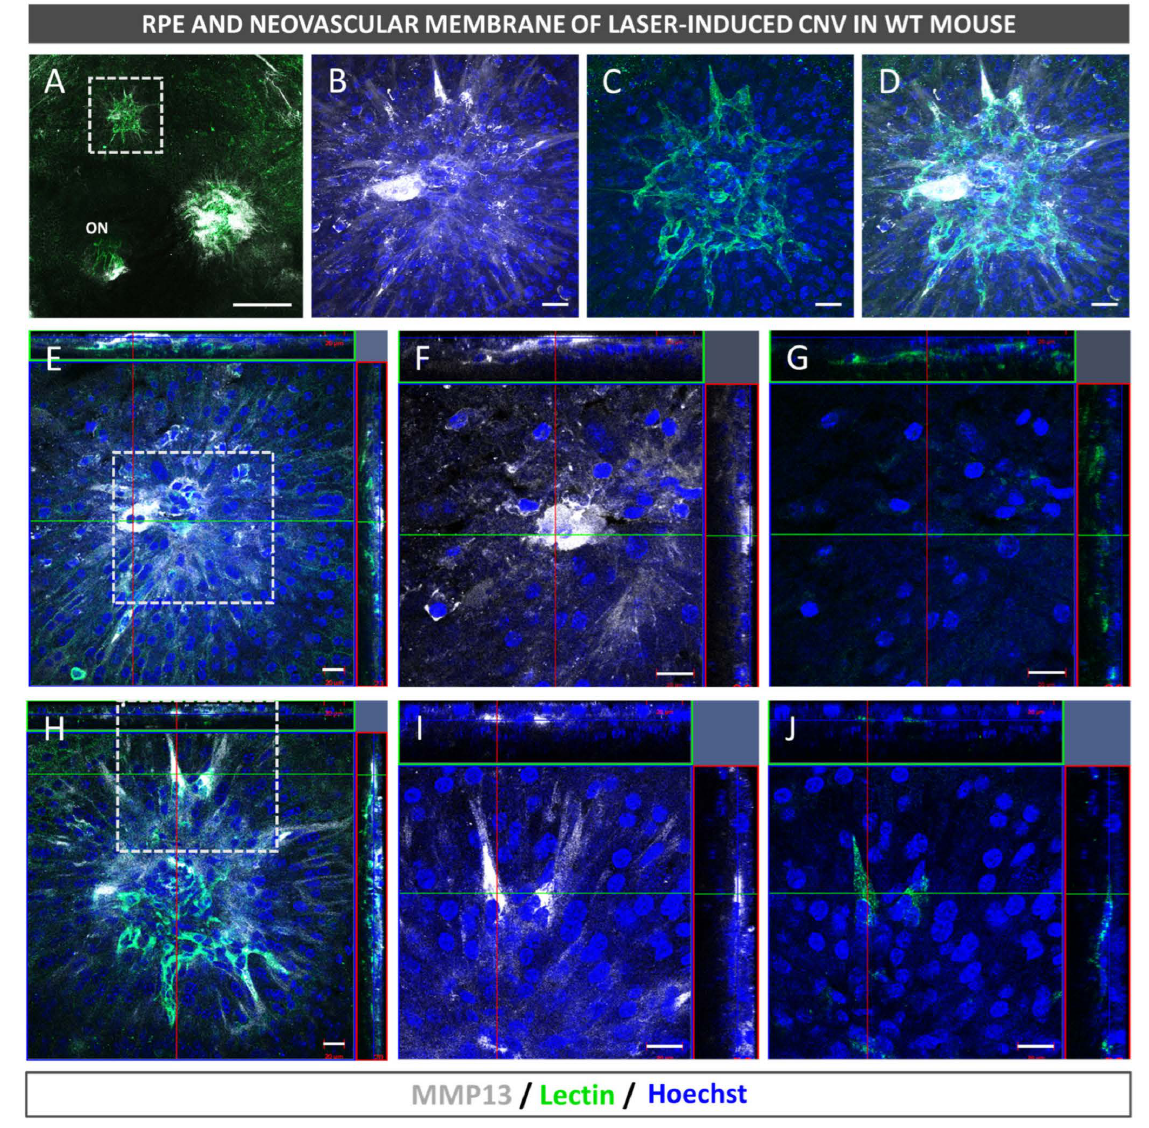
Figure 5. MMP13 is overexpressed in CNV, showing expression in RPE cells and endothelial cells. Representative laser-induced CNV lesions on choroidal flatmounts from WT mice stained with MMP13 (white), lectin (green), and Hoechst 33342 (blue). ( A ) Whole flatmount micrograph with successfully induced CNV. The outlined region represents the CNV shown in ( B – J ). ( B ) Magnification of CNV area showing increased MMP13 expression. ( C ) The neovascular membrane is clearly visible and stained with lectin (green). ( D ) Merged image of the MMP13 and lectin staining. ( E ) Orthogonal view of the obtained z-stack at RPE level. ( F ) The RPE showed MMP13 expression, especially in the center of the CNV. ( G ) No lectin-positive cells were observed at this level. ( H ) Orthogonal view of the obtained z-stack at the level of the CNV. ( I ) ECs were MMP13-positive. ( J ) Endothelial cells were lectin-positive (green). n = 8. Hoechst 33342, blue; lectin, green; and MMP13, white. EC = endothelial cells. CNV = choroidal neovascularization. MMP13 = Matrix metalloproteinase 13. ON = optic nerve. RPE = retinal pigment epithelium. WT = wild type. Scale bars: 20 µ m ( B – J ), 200 µ m ( A